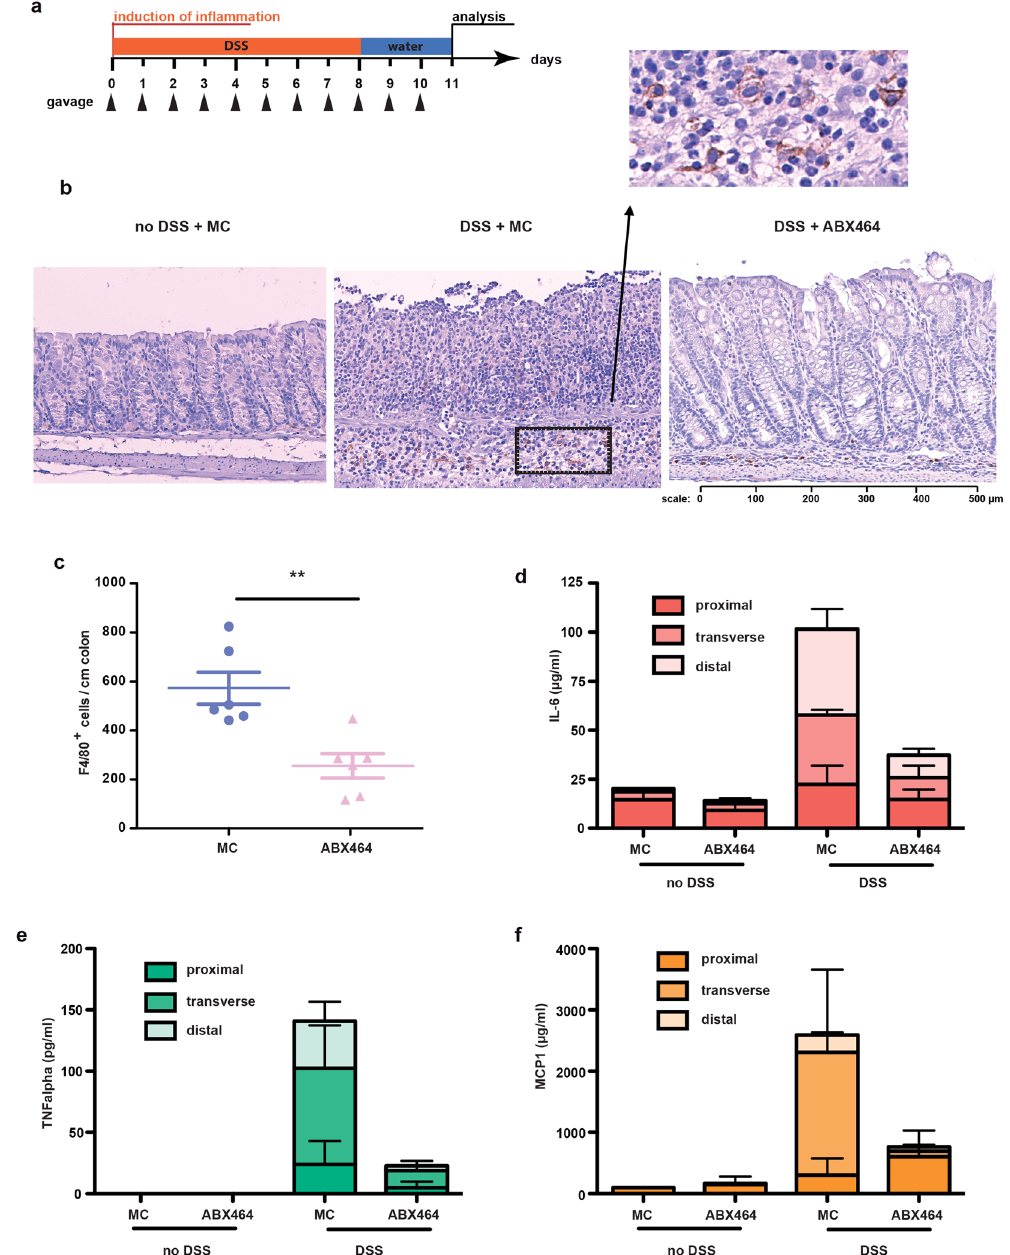
Figure 3. ABX464 decreases macrophage presence and pro-inflammatory cytokine production during acute colitis. (a ) Acute colitis was induced as described in Fig. 1a. ( b ) Colons were analyzed for macrophage content by F4/80 labeling. Representative images of macrophage presence in colons of MC only treated mice (left hand panel), MC and ABX464 treated mice exposed to DSS are presented. ( c ) Total number of F4/80 + macrophages per colon per mouse are are shown (n = 8 each cohort). ( d–f ) Colons were taken at the end of the protocol, dissected in the proximal, middle and distal region and maintained in culture for 24 hours. Culture supernatant were analyzed for production of IL-6 ( d ), TNFalpha ( e ), and MCP-1 ( f ) by CBA as described in Methods